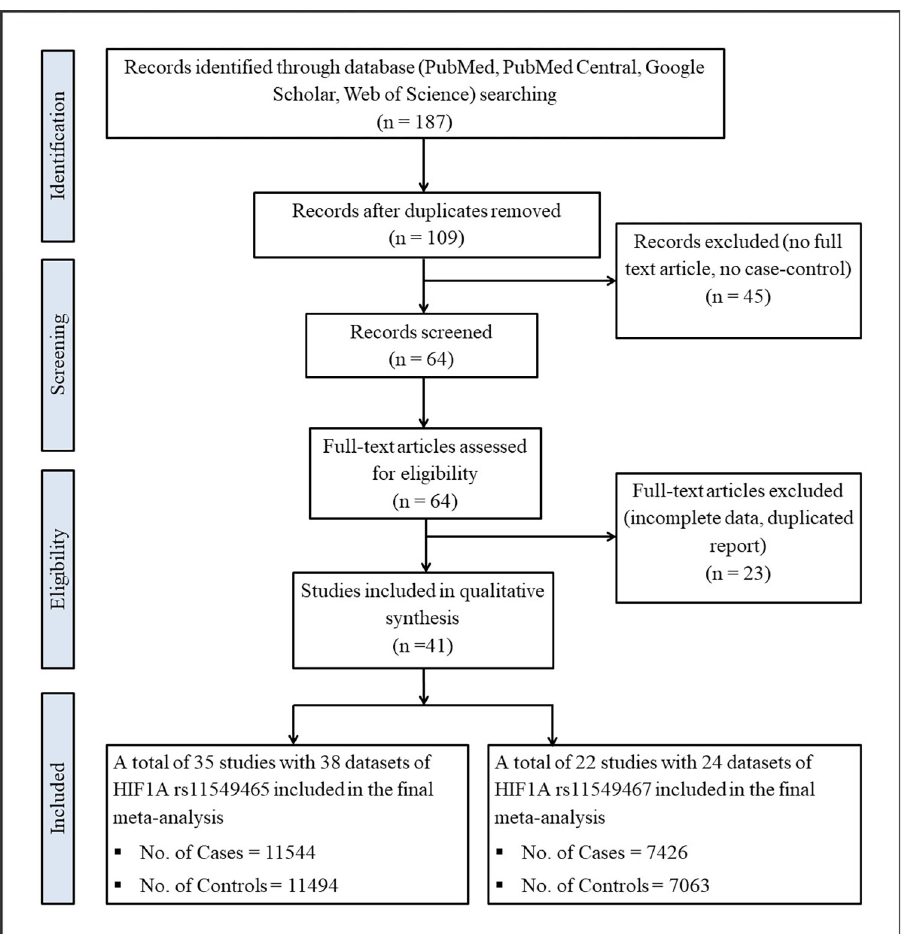
Fig 1. Flow diagram for study selection with HIF1A gene polymorphisms rs11549465 and rs11549467.